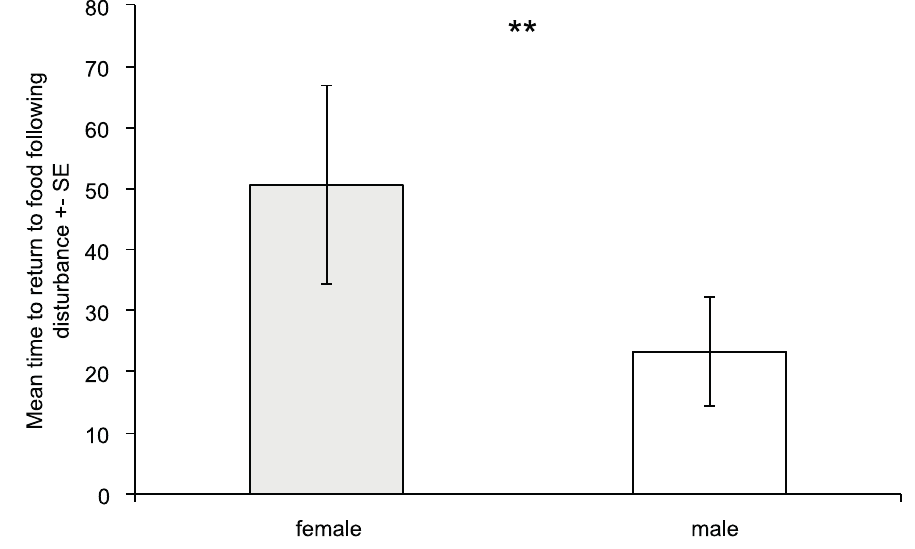
Figure 6. Sex differences in boldness: males are significantly bolder than females.